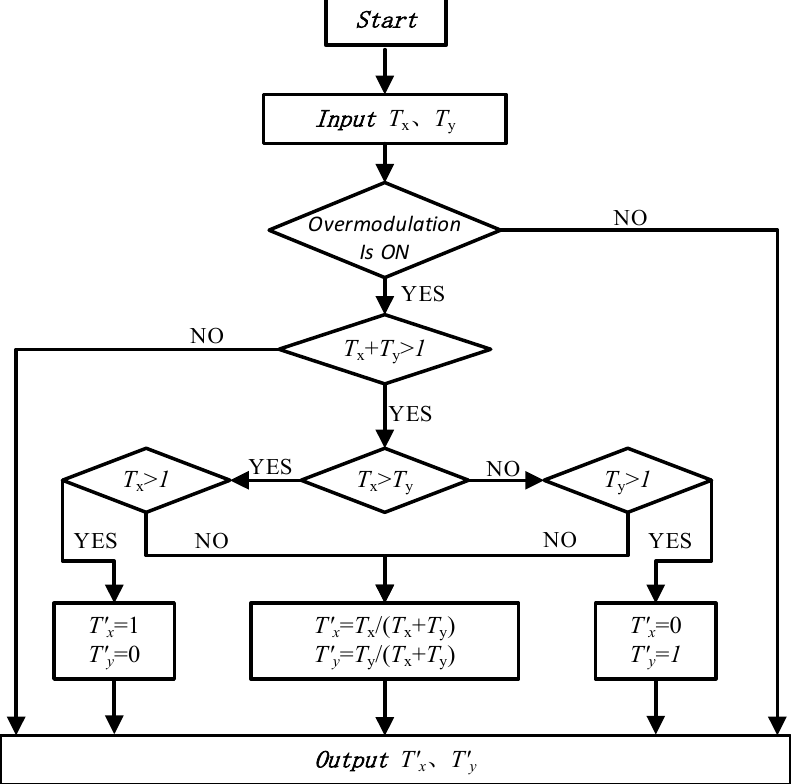
the overmodulation of each sector of SVPWM. The flow chart of overmodulation pro- cessing in any sector is shown in Figure 11, and the input values T x and T y are the action time of two adjacent basic voltage vectors. As this IP was normalized in data processing, 1 was the switching period. Figure 10. Schematic diagram of the first sector of SVPWM modulation. Figure 10. Schematic diagram of the first sector of SVPWM modulation.